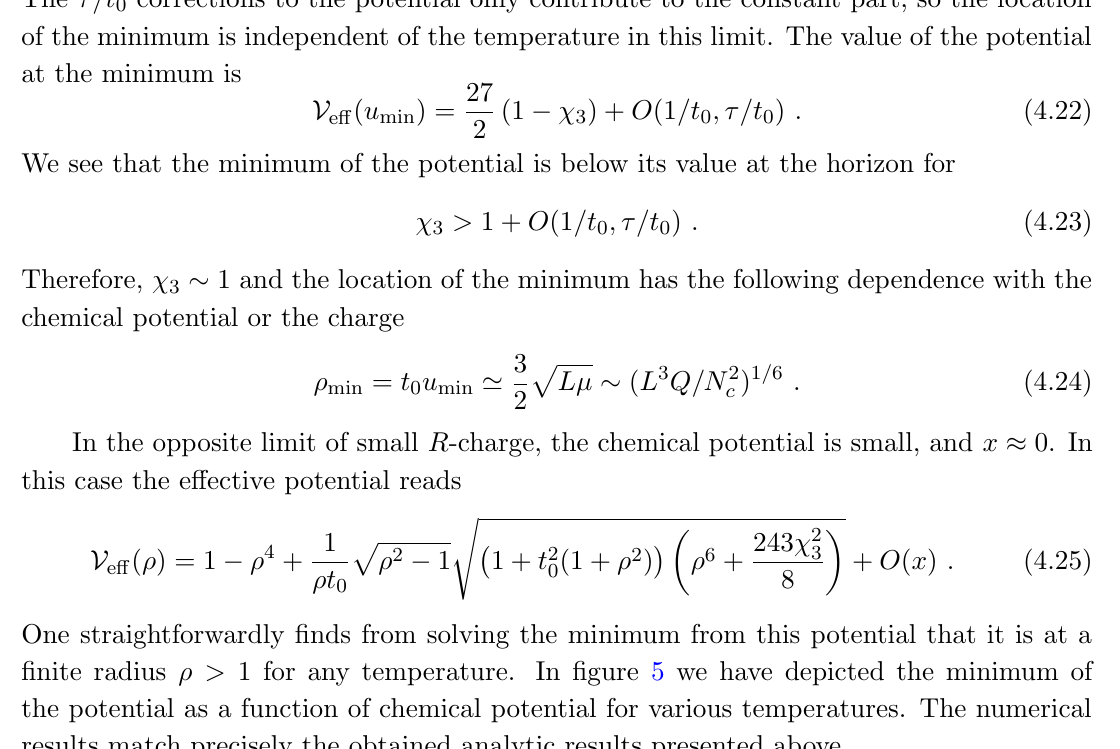
p ’ 3 L(cid:22) (see (4.24)) r H 2